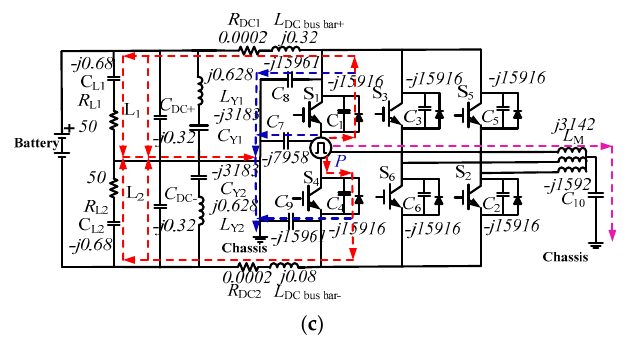
Figure 7. ( a ) Equivalent circuit for CM; ( b ) Equivalent circuit for CM; ( c ) CM interference propagation path at 500 KHz.